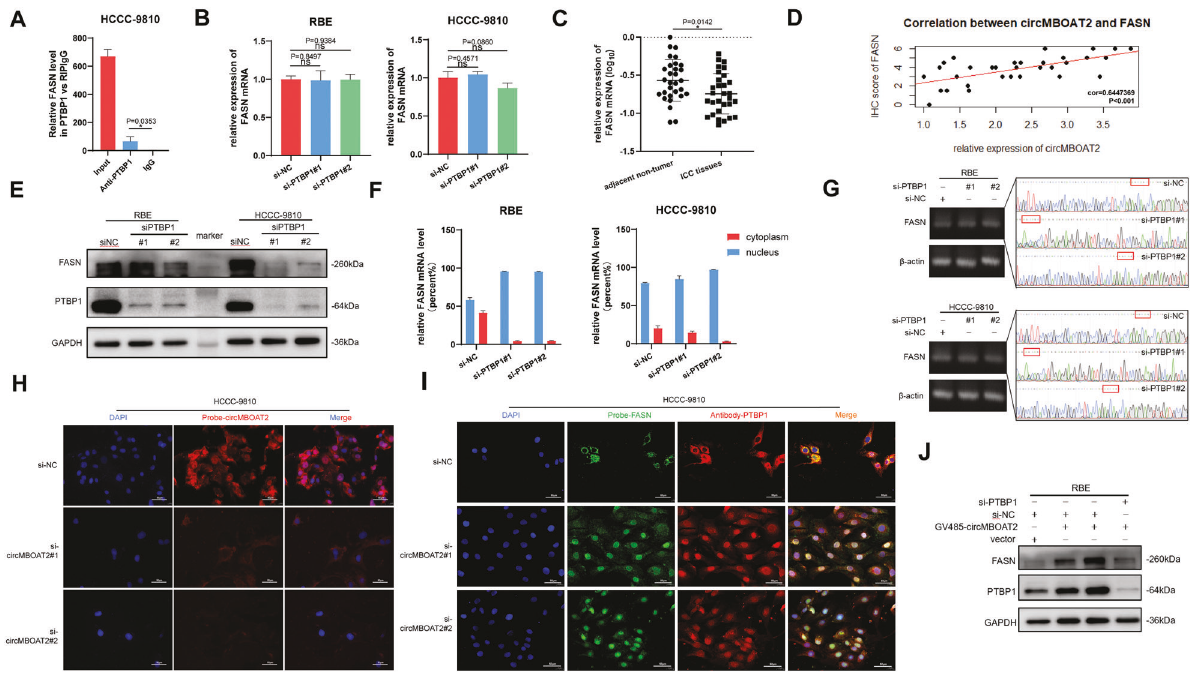
Fig. 6 CircMBOAT2 promotes PTBP1-mediated cytoplasmic export of FASN mRNA. A RIP assay. FASN mRNA was precipitated by an anti- PTBP1 antibody speci fi cally and detected by qRT-PCR in HCCC-9810 cells. IgG was used as a negative control. B The mRNA expression of FASN was determined with qRT-PCR, which was normalized to β -actin after PTBP1-knockdown in RBE and HCCC-9810 cells. C The qRT-PCR method was applied to detect the mRNA levels of FASN in 27 ICC patients and normal tissues adjacent to cancer. The expression of FASN was normalized to β -actin. Signi fi cant differences between groups were analyzed by paired sample t -test. D Correlation between the expression of circMBOAT2 and FASN protein by Pearson correlation analysis. E Western blot showed the protein levels of PTBP1 after PTBP1 knockdown in RBE and HCCC-9810 cells. GAPDH was used as a negative control. F The nuclear and cytoplasmic fractions were obtained by isolation. The qRT-PCR method was used to detect the mRNA levels of FASN in nuclear and cytoplasmic fractions of RBE and HCCC-9810 cells transfected with si-NC, si-PTBP1#1 or si-PTBP1#2. G PCR and Sanger sequencing for RBE and HCCC-9810 cells after PTBP1 knockdown. H , I The relative protein levels of PTBP1 and mRNA levels of FASN and the relative levels of circMBOAT2 after PTBP1 knockdown in HCCC-9810 cells were detected by immuno fl uorescence or FISH assays. Scale bar = 50 μ m. J The protein levels of PTBP1 and FASN were determined by western blot analysis after PTBP1 knockdown and circMBOAT2 overexpression in RBE cells. Error bars represent the means ± SEM of three independent